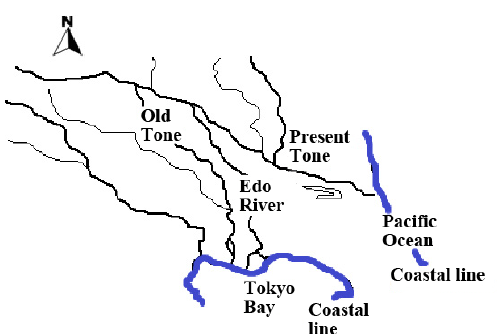
Figure 2. Eastward diversion of the Tone River.